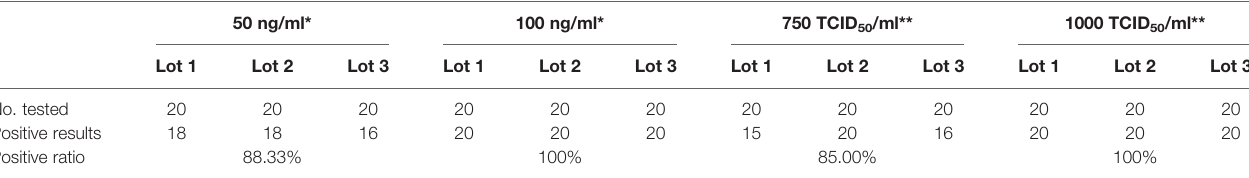
TABLE 1 | Limit of